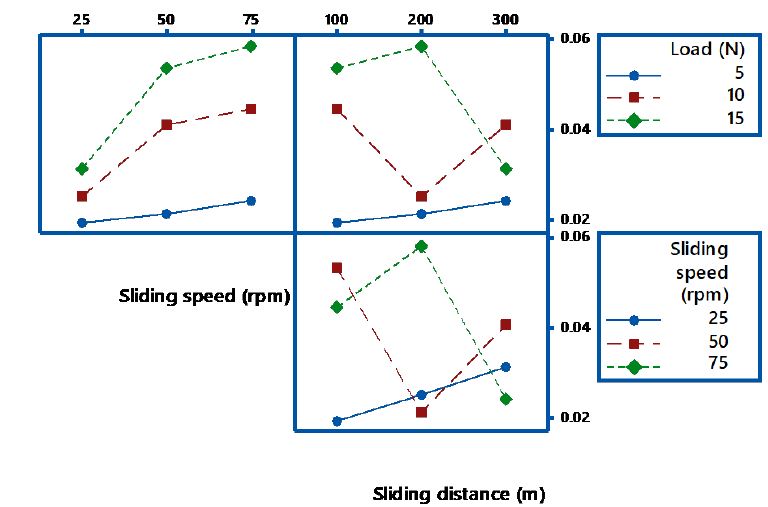
Figure 5. Interaction plot for wear loss.